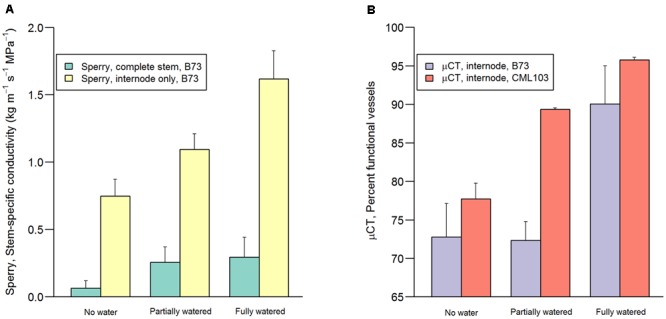
Stem-specific conductivity measured on the Sperry apparatus (A) and percent water-filled (functioning) vessels measured via μCT (B) in the three water treatments (‘no water,’ ‘partially watered,’ ‘fully watered’) after the overnight recovery period (10 h). Green and yellow bars represent stem-specific conductivity measured in complete stem sections (lumen + pit resistance) and in internodes (lumen resistance) of inbred B73 (left-side y axis). Purple and orange bars represent the percent functional vessels measured in inbreds B73 and CML103 via μCT. Error bars represent 1 SD.